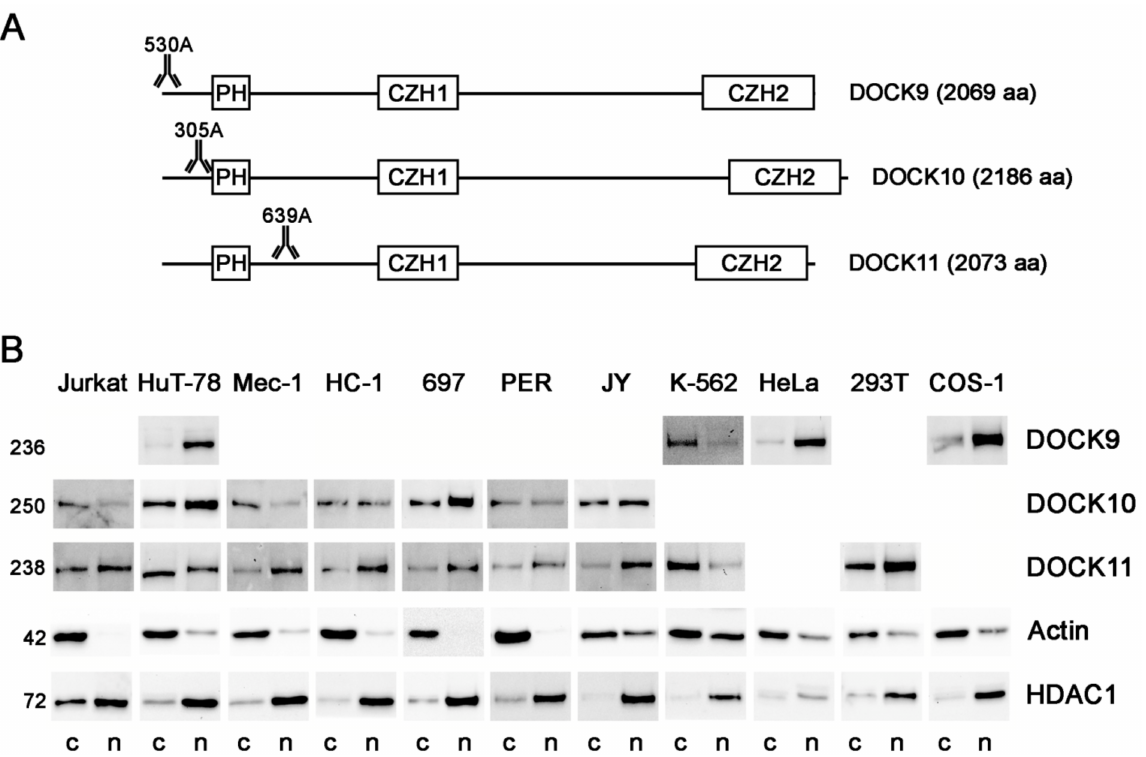
Figure 1. Distribution of DOCK9, DOCK10, and DOCK11 proteins between the cytosol and nucleoplasm of cell lines. ( A ) Diagram of the main domains of the DOCK-D proteins indicating the approximate positions targeted by the Abs used in the present study. 530A, 305A, and 639A are identifiers of the commercial Abs used (short catalog nos., Table 2). ( B ) WB analyses of DOCK9, DOCK10, and DOCK11 expression in the cytoplasmic and nuclear fractions of 11 cell lines using